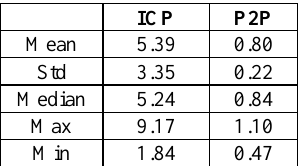
Table 3. Statistics on misclosure RMSE (in